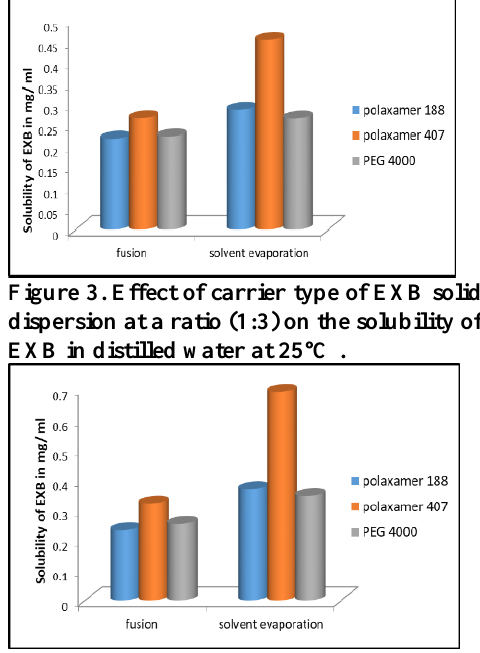
Figure 4. Effect of carrier type of EXB solid dispersion at a ratio (1:5) on the solubility of EXB in distilled water at 25°C In-vitro release of EXB solid dispersion Effect of polymer type